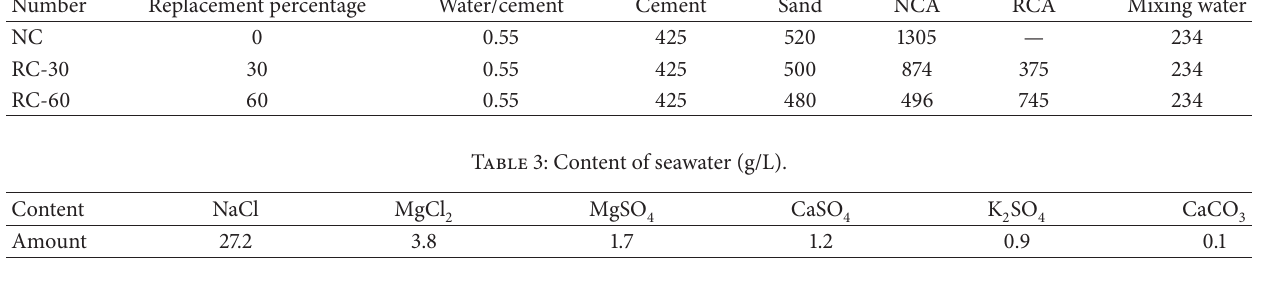
Table 4: Compressive strength of RAC with seawater corrosion (MPa).